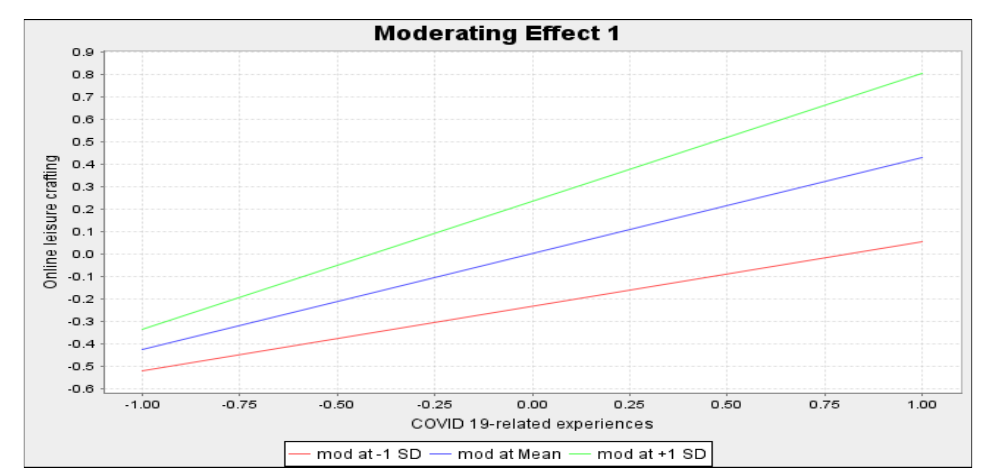
Figure.3. Moderating effect analysis